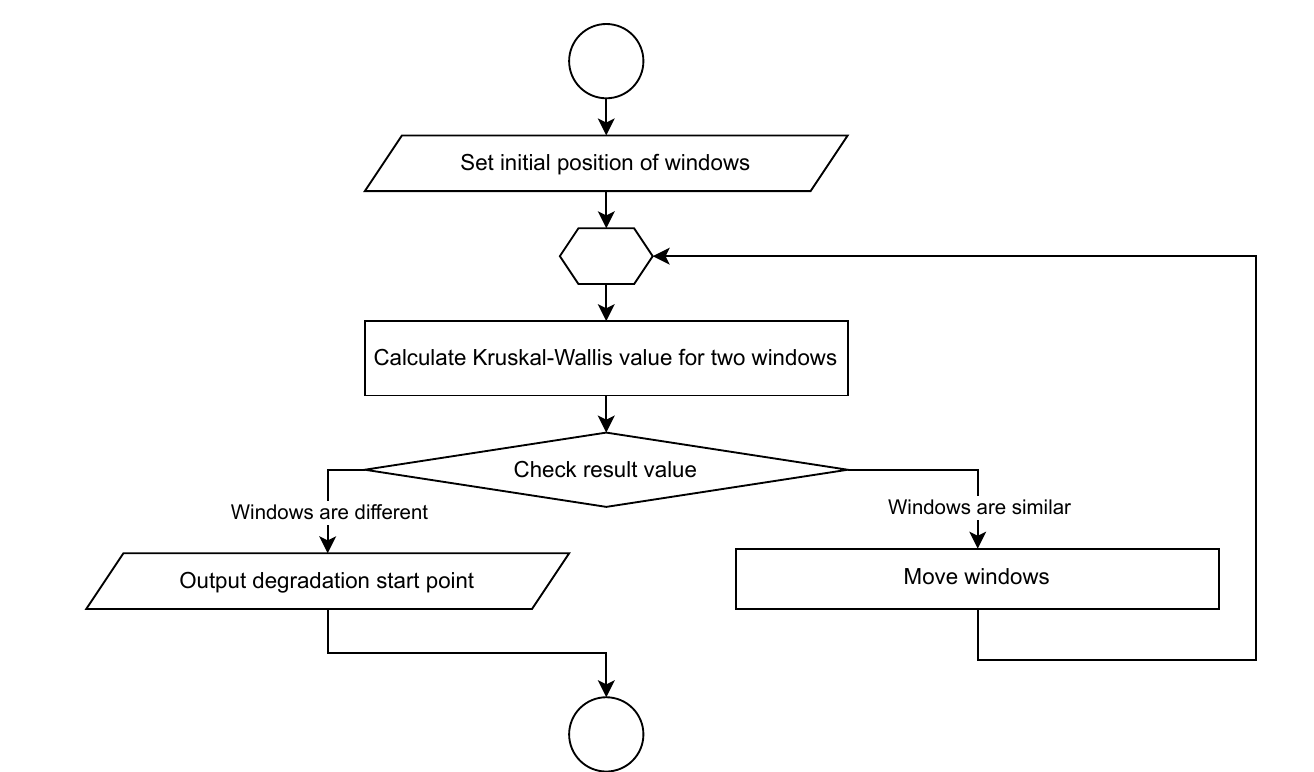
Figure 11. Proposed method for determination of degradation start